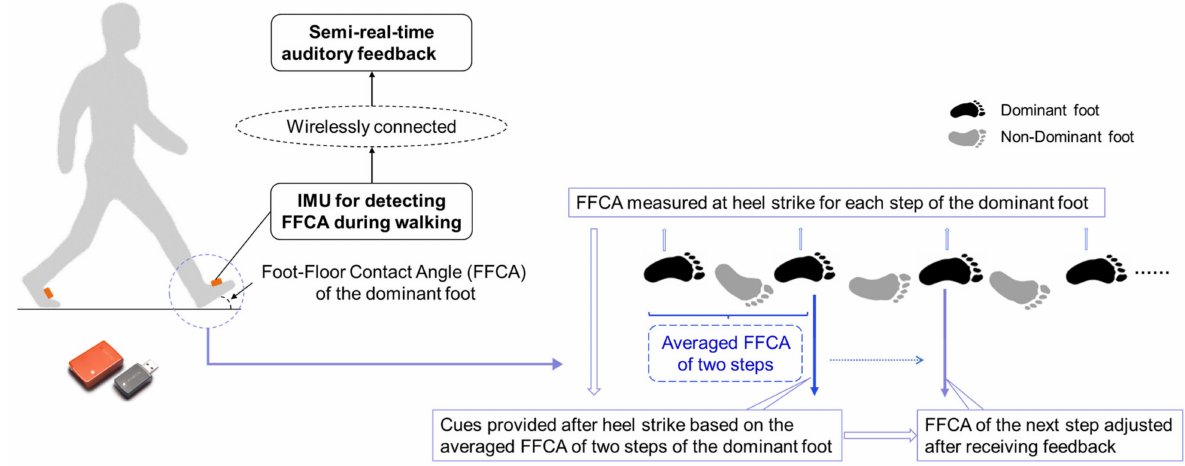
Figure 1. The semi-real-time system for providing feedback about the